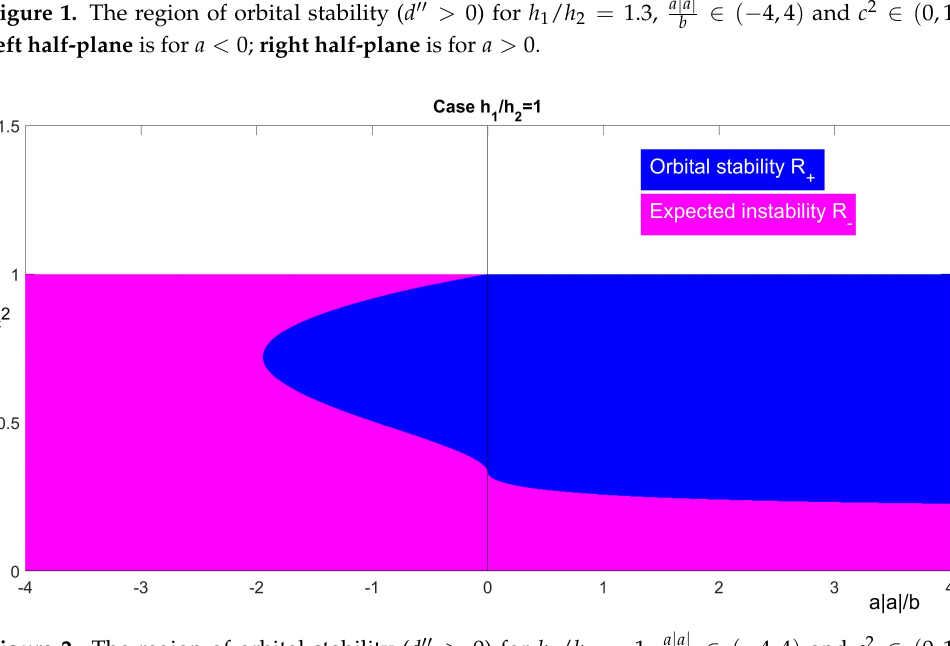
Figure 2. The region of orbital stability ( d (cid:48)(cid:48) > 0) for h 1 / h 2 = 1, a | a | left half-plane is for a < 0; right half-plane is for a >